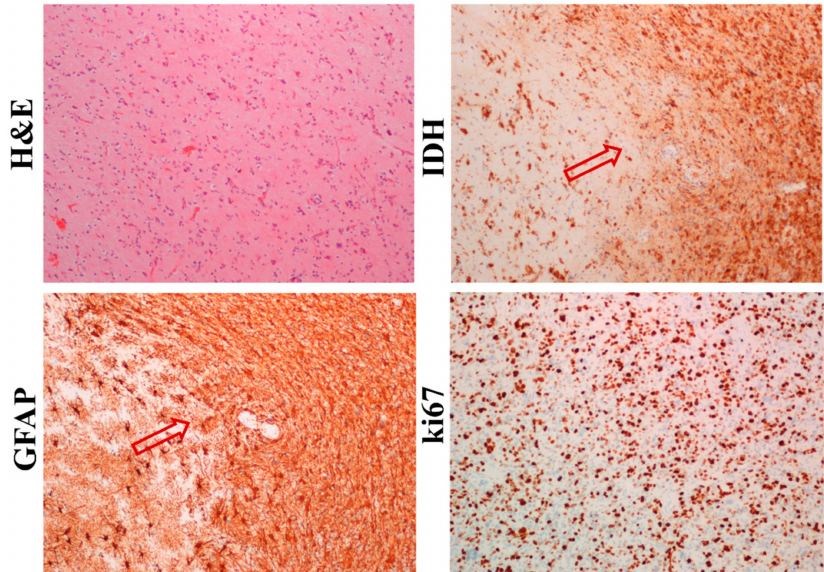
Figure 1. Immunohistochemical analysis of the glioblastoma (GBM) sample (sample No. 1). GBM samples were processed and GFAP, IDH, ki-67, and haematoxylin and eosin were detected by immunohistochemistry and histochemistry, as described in the Materials and Methods section. Bright-field microscopy, 100 × , scale. Arrows show the GBM margin.